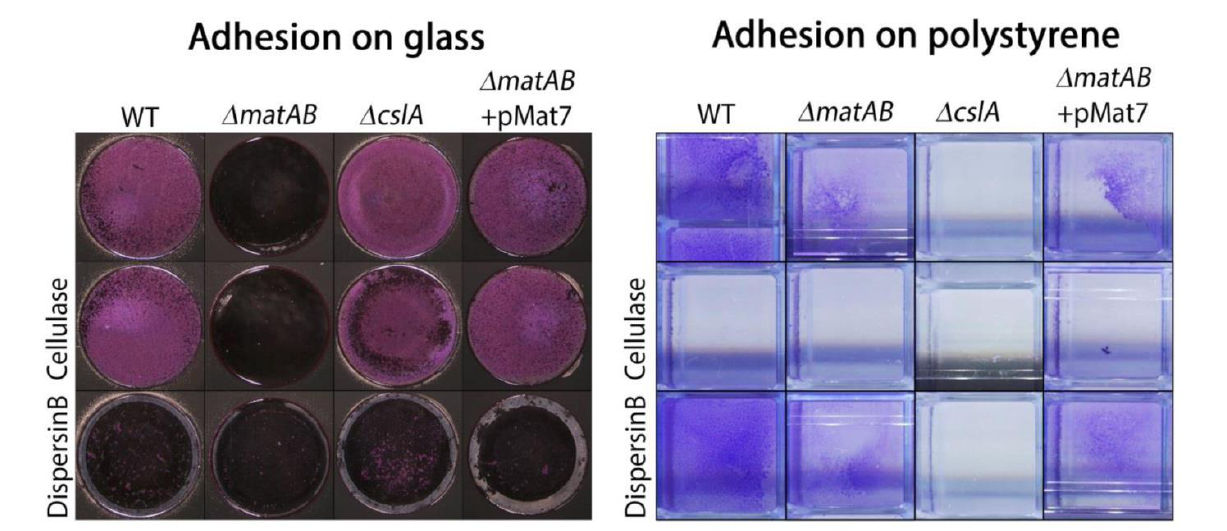
FIGURE 6: Adhesion assays visualizing EPS-mediated attachment to glass and polystyrene . Attachment of S. lividans 66 to glass was antag- onized by treatment with dispersin B (50 µg/ml) or by deletion of matAB , while addition of cellulase (0.2 U/ml) or deletion of cslA had no effect. The opposite was seen for attachment to polystyrene, which was antagonized by cellulase or by deletion of cslA and not by dispersin B or deletion of matAB . The ability to attach to glass was restored to matAB mutants by the introduction of plasmid